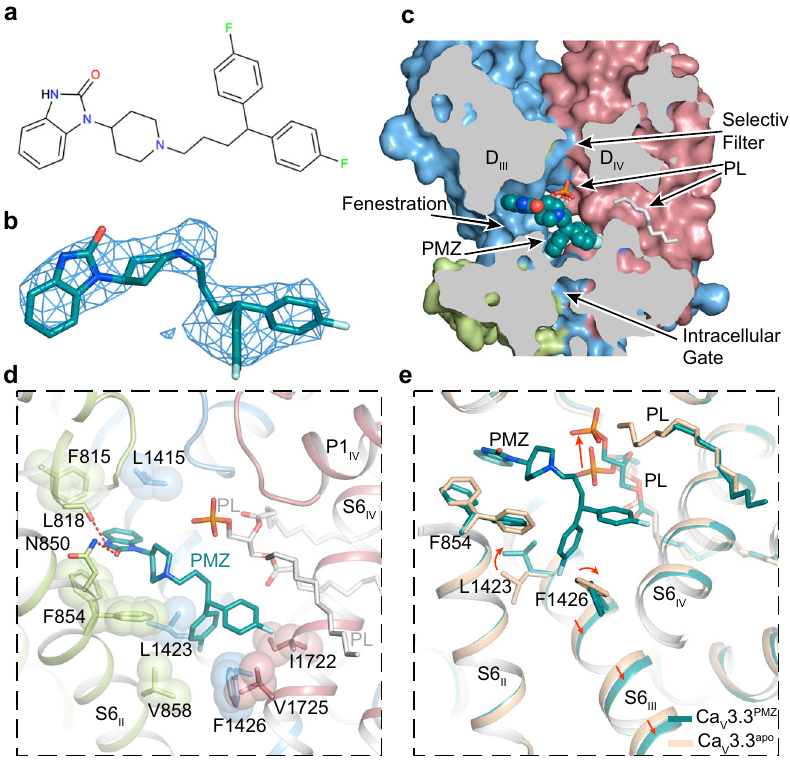
Fig. 5 Structure basis for blockade of Ca V 3.3 by pimozide. a Chemical structures of pimozide. b The cryo-EM density shown in blue mesh for PMZ in sticks. c Cross-sectional view, showing the open selectivity fi lter, fenestrations, pore domain where PMZ (blue spheres) located and intracellular gate. Phospholipids entering through other fenestrations are displayed as white sticks. d Detailed binding sites for pimozide. The side chains of key residues are displayed in sticks and the hydrophobic side chains are overlaid with transparent surfaces. Black dashed lines indicated potential hydrogen bonds. e Comparison of Ca V 3.3 PMZ with Ca V 3.3 apo (wheat). The shifts of the backbone of S6 III helix and side chain of L1423 and F1426 and phosphate group of the phospholipid are indicated by red